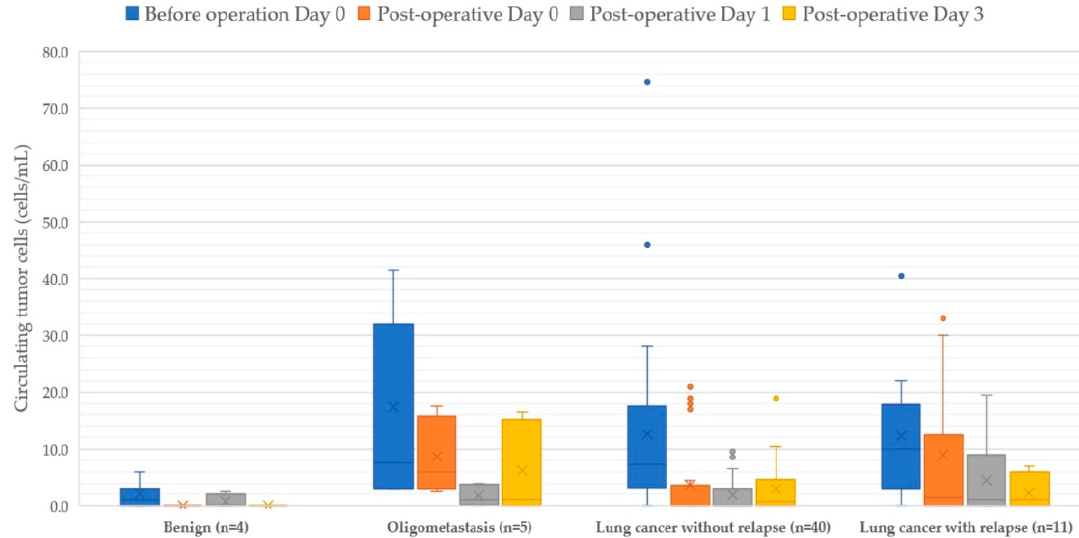
Figure 4. Boxplots of circulating tumor cells within 3 days of surgery.